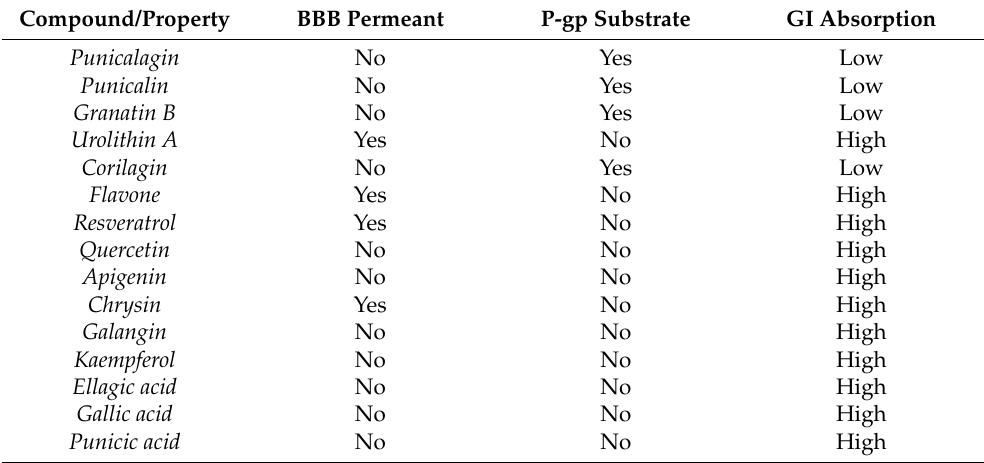
Table 4. Absorption and distribution properties of the main phytochemicals by SwissADME. Compound/Property